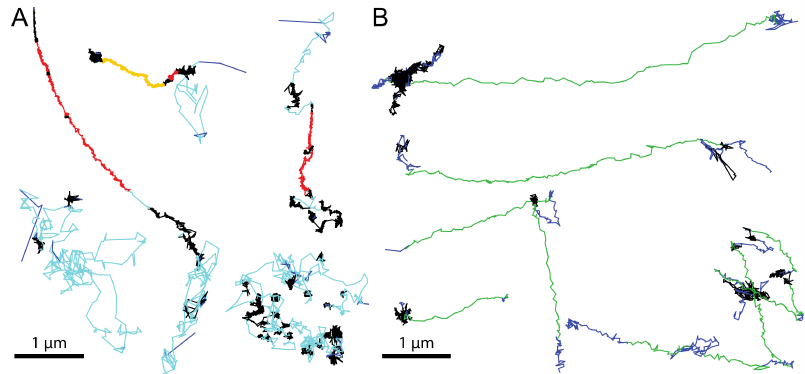
Figure 3. Examples of virion trajectories on the cell surface and in the cytosol. Segmented trajectories from AdV at the cell surface ( A ) and in the cytoplasm ( B ). Cell surface motion was classified in diffusion (cyan), slow drift (red), fast drift (orange), confined motion (black) and not classified steps (blue). Cytoplasmic motion was classified into directed motion (green), fast and slow drifts (orange and red, respectively), confined motion (black) and not classified steps (blue). Scale bars are 1 µ m. Technical details of the tracking and segmentation procedures are described in [27]. The segmented tracks in panel A were derived from previously published data, and adapted with permission from Elsevier [27]. The segmented tracks in panel B were adapted from [183], with permission from The Company of Biologists